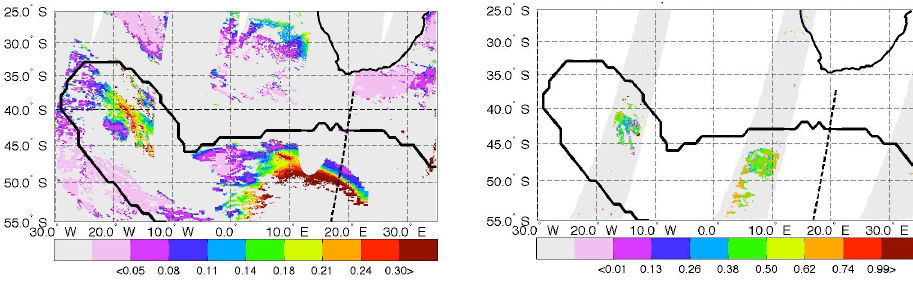
Fig. 11. MODIS-Terra AOTs (left) and MISR non-spherical fraction (right) for 3 March. MODIS images are composites of two consecutive Figure 11: MODIS-Terra AOTs (left) and MISR non-spherical fraction (right) for overpasses (at 10:55 and 12:35UTC). North to South dashed line is the track of GLASS at March 03. MODIS images are composites of two consecutive overpasses (at 10:55 and 12:35 UTC). North to South dashed line is the track of GLASS at 14:13 UTC.